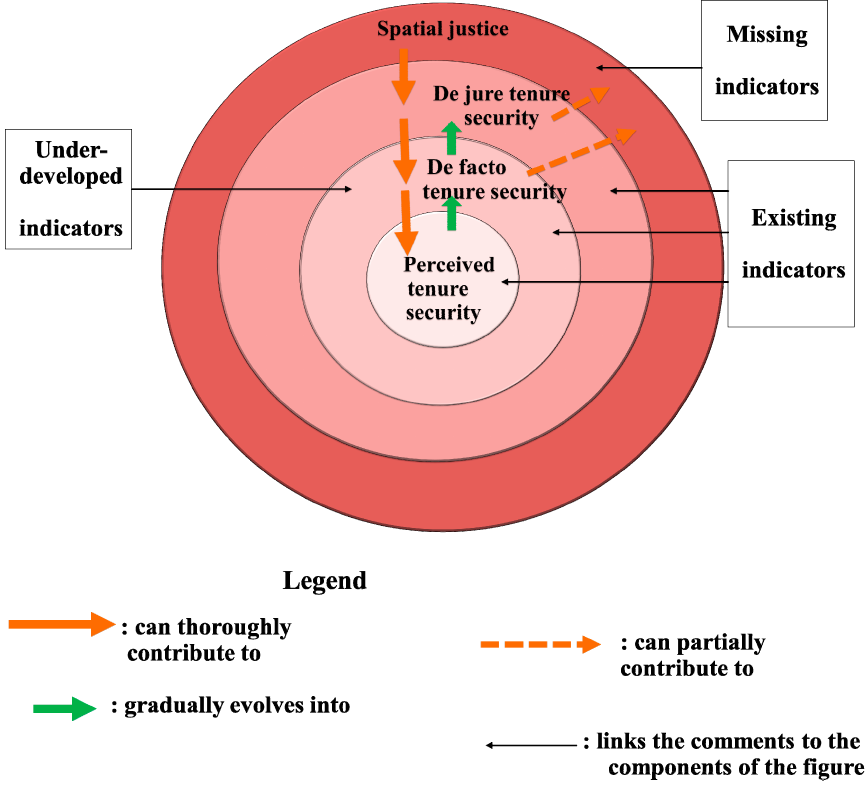
Figure 2. Scale of land tenure security and relation to evaluative indicators. Developed based on [39,104,105,107,108].